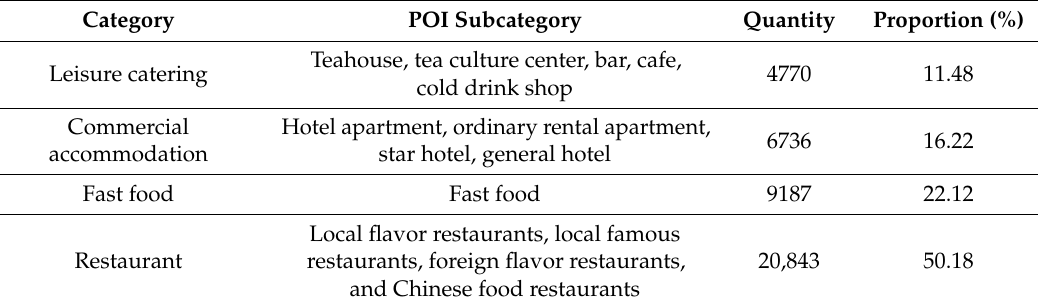
Table 1. Point of interest (POI) categories of accommodation and catering in Beijing.